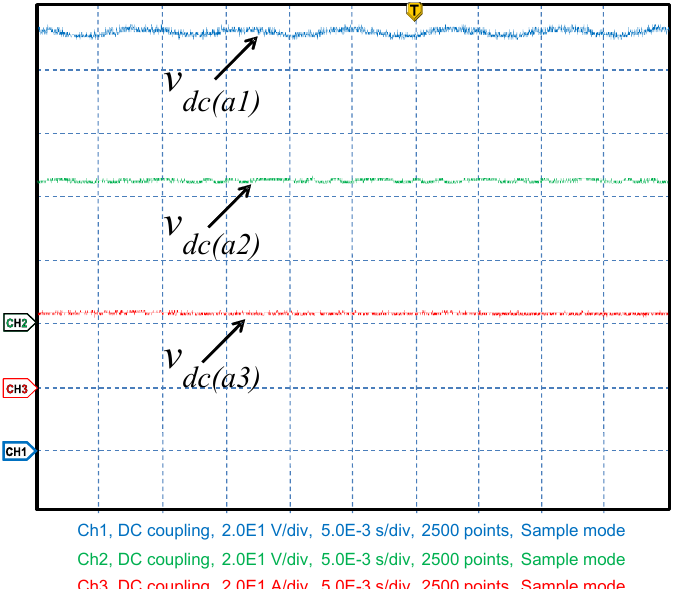
Figure 11. Experimental result—dc-link voltage